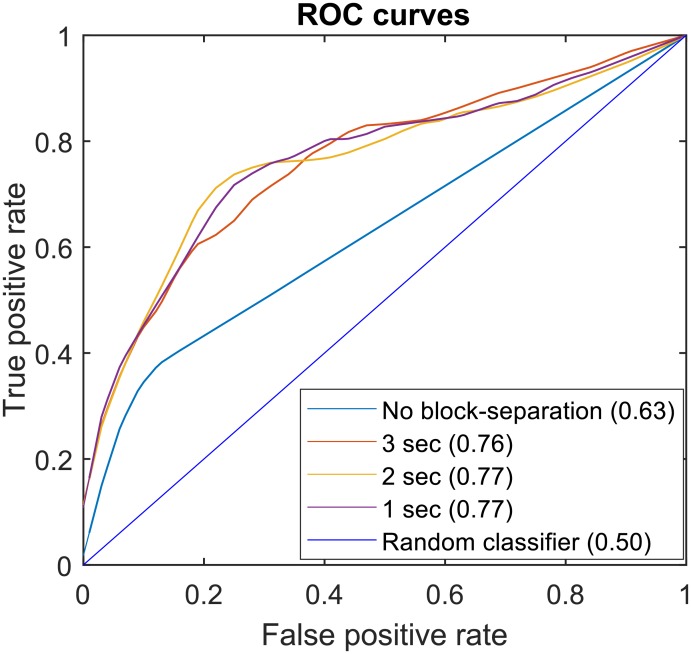
Representation of the analysis of four statokinesigrams that have not easily distinguishable statokinesigrams(two fallers, two non-fallers) deduced from the CoP antero-posterior and medio-lateral using block-length of 1 second.It can be observed that although all the examples include parts that are strongly classified as possible UBs, these parts are more frequent in fallers than in non-fallers.